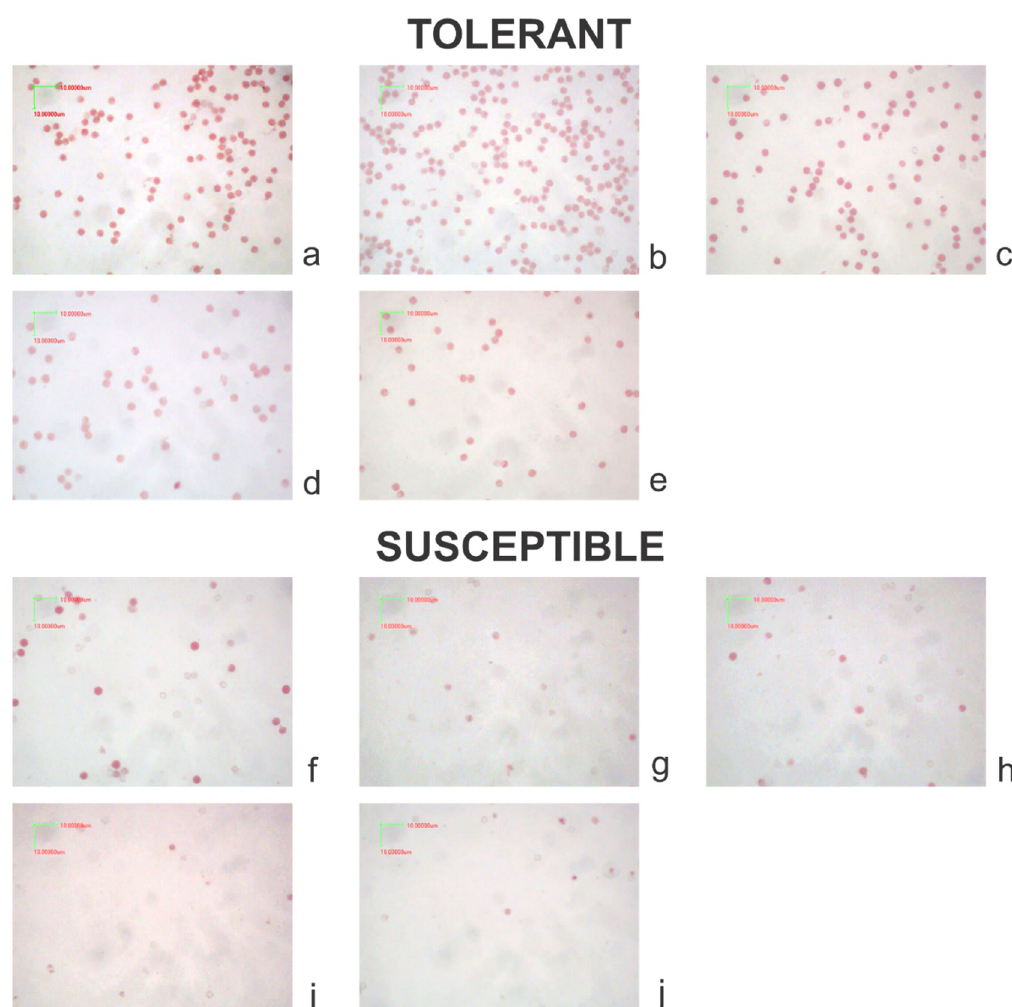
Fig 1. Pollen viability assay of heat-tolerant and heat-susceptible tomato